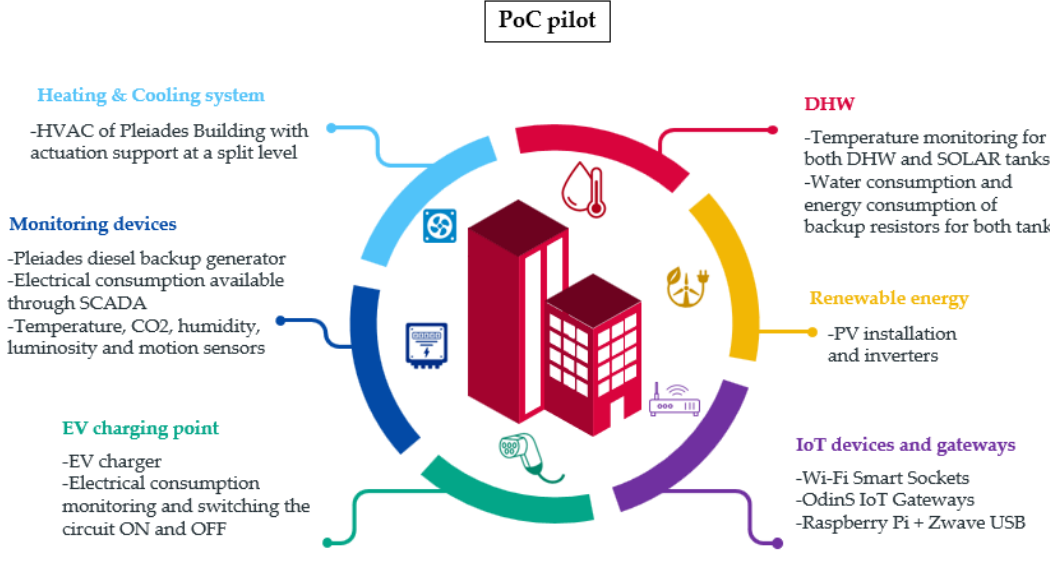
Figure 3. Asset layer of PoC pilot site.